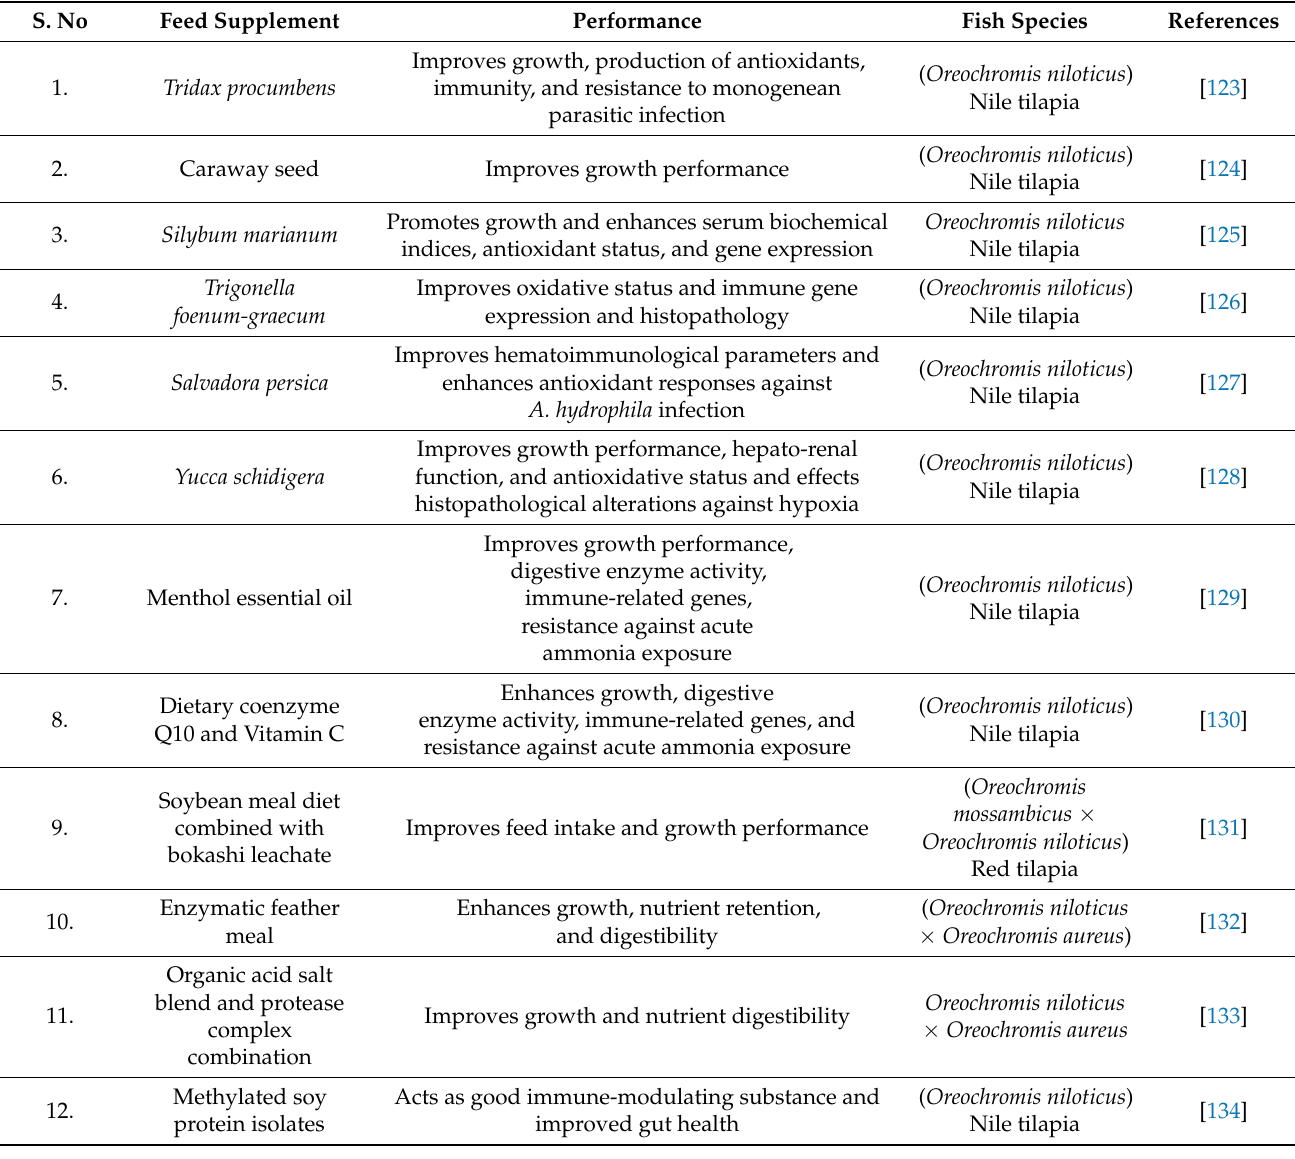
Table 1. Various feed supplements and their performance with respect to fish